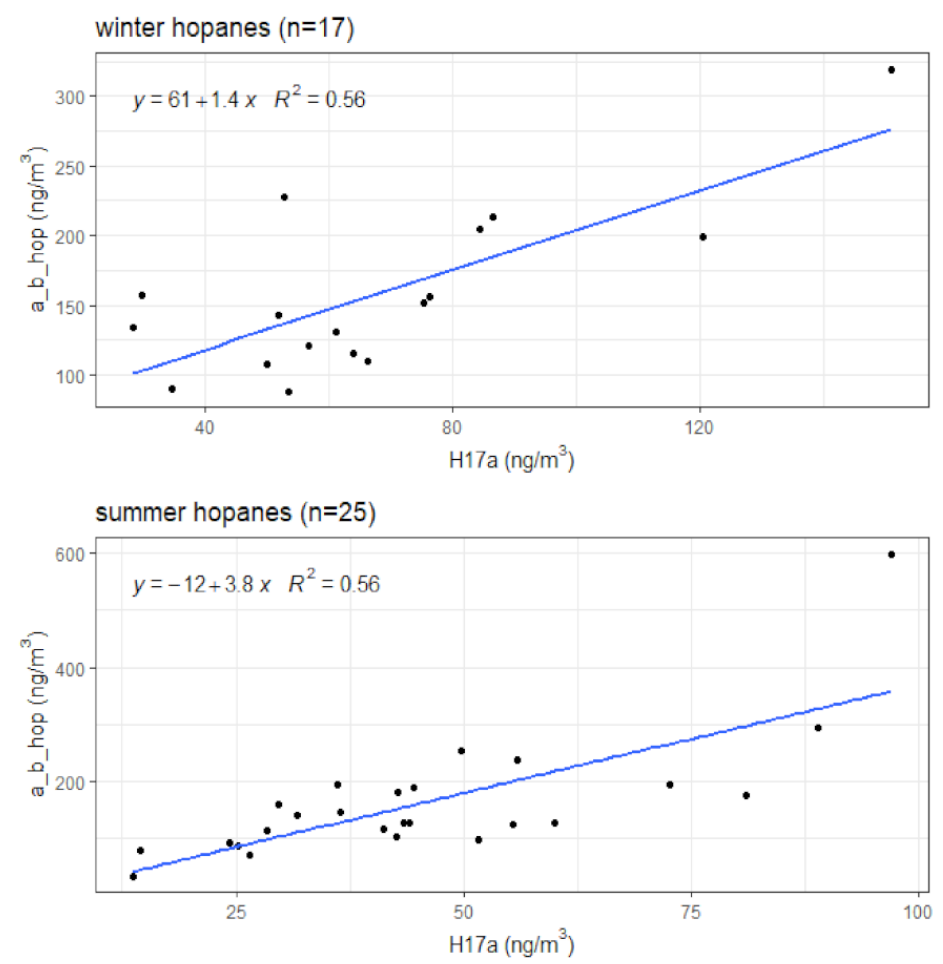
Figure 1. Estimation of a_b_hop: H17a ratios by season using LSR